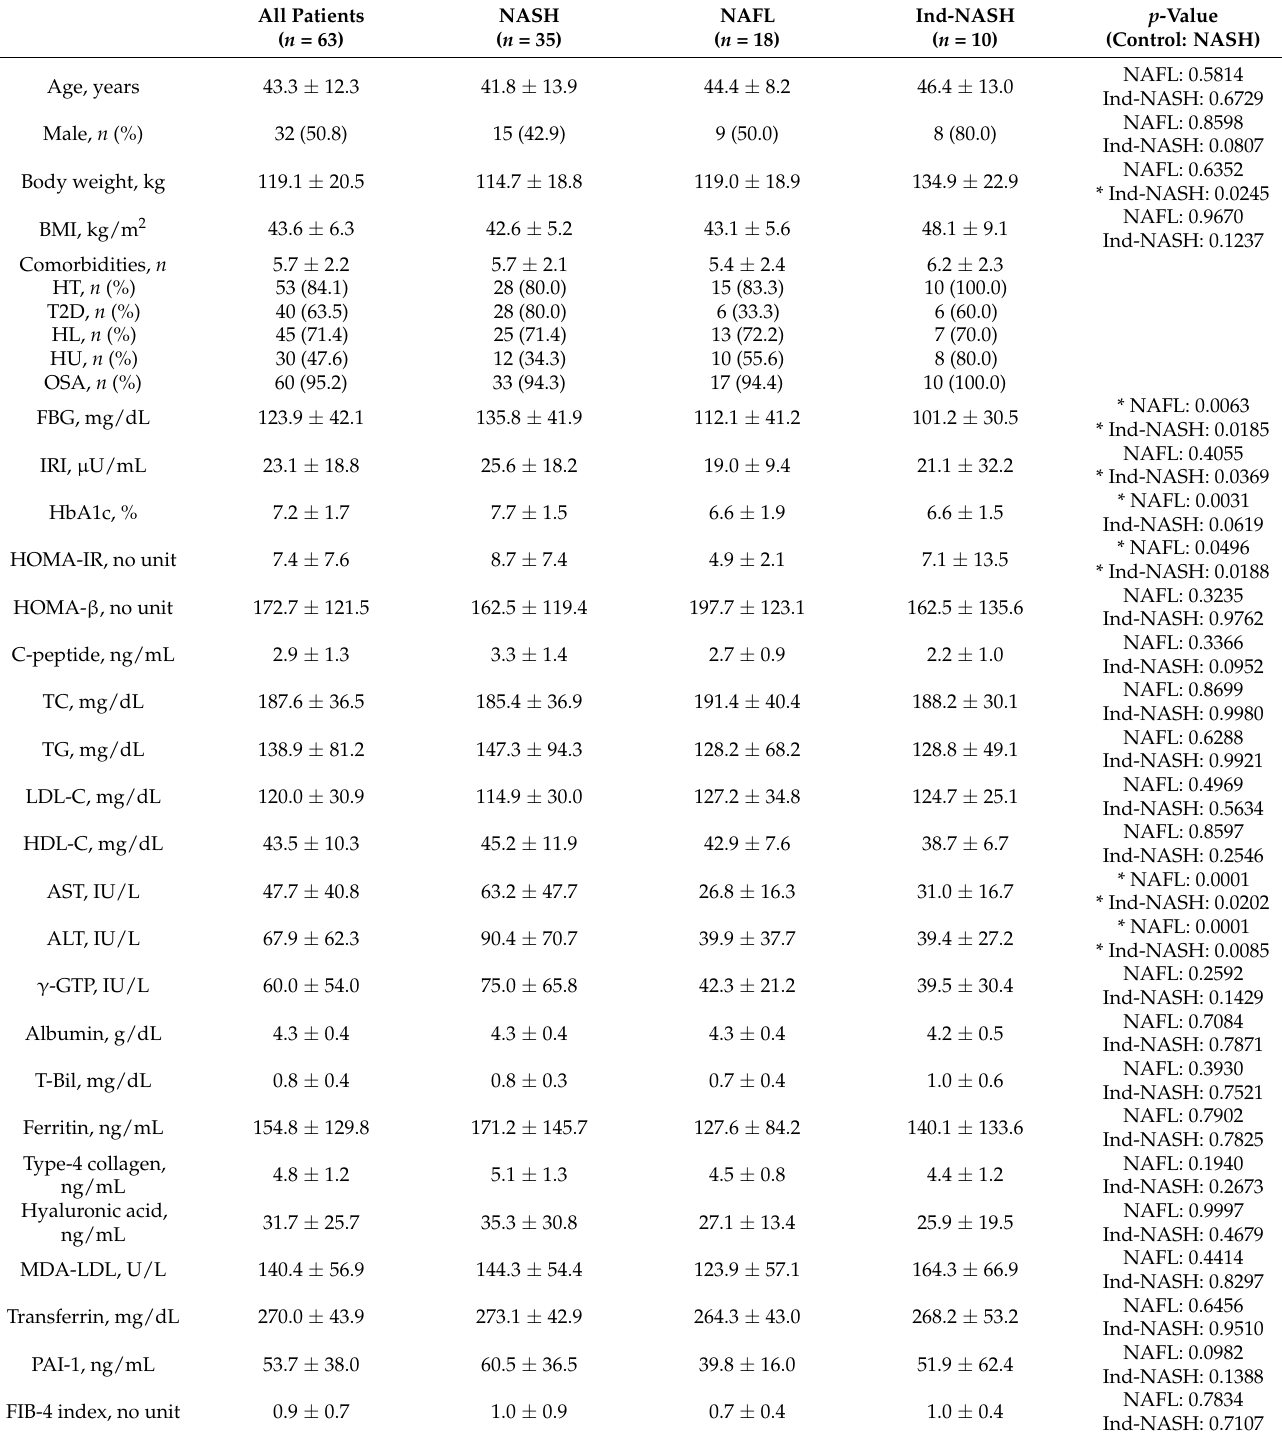
Table 1. Baseline characteristics of enrolled patients and stratifications along with intraoperative liver